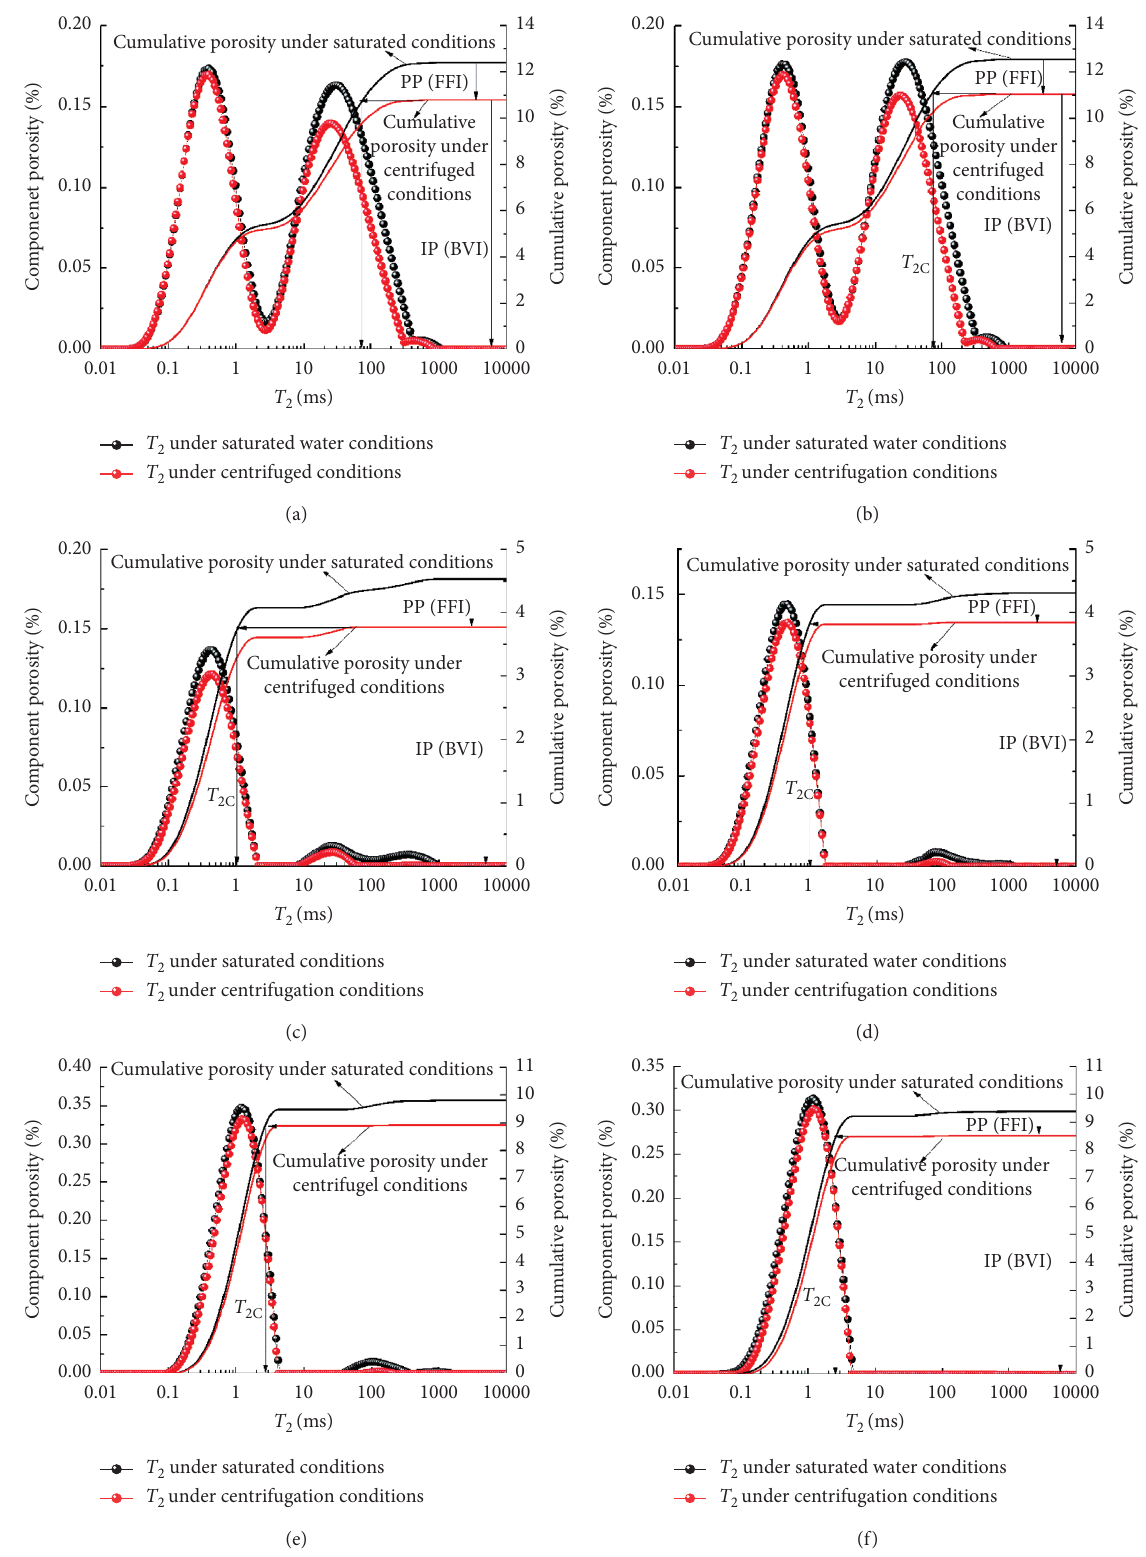
Figure 8: Movable fluid porosity and bound fluid porosity, showing the method to calculate T (e) ZM-1, and (f)